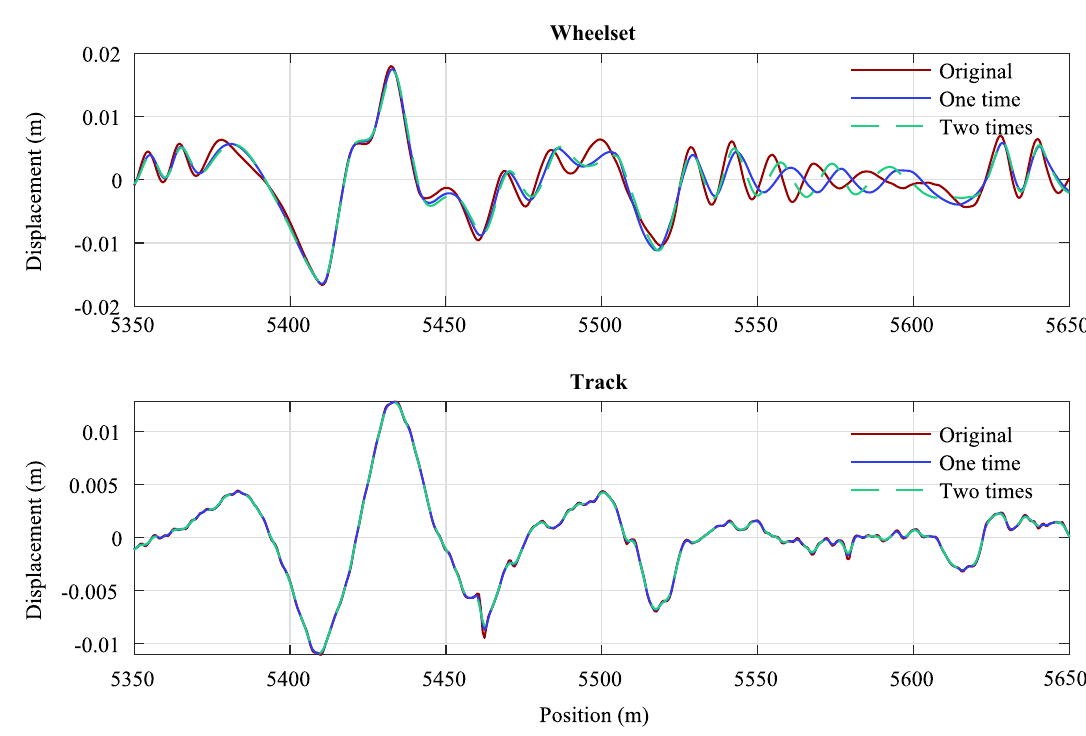
Fig. 7 A simulation using the original data, a simulation using the data after using the kernel once and a simulation after using the kernel twice on the original